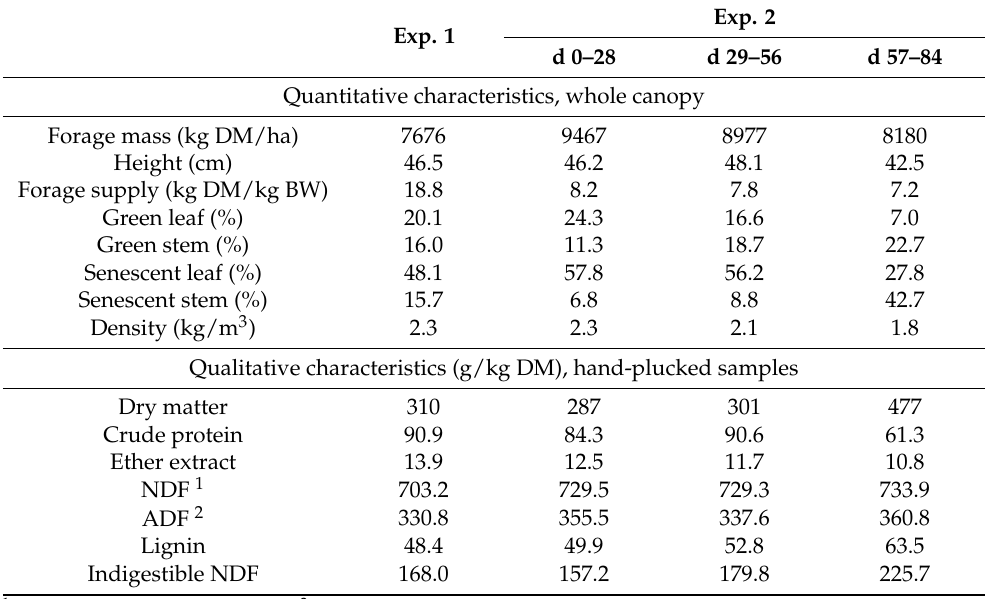
Table 2. Quantitative and qualitative characteristics of Urochloa brizantha cv. Marandu during the growing phase of Nellore